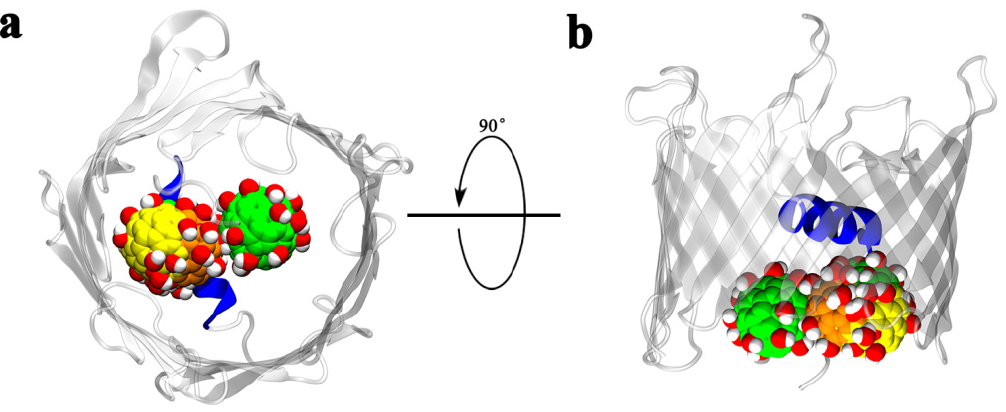
Figure 5. The superimposition of the three representative runs based on the backbone of hVDAC1 to show the relative positions of Gd@C 82 (OH) 22 molecules that penetrated the pore from the IM. Top view from IM is shown in ( a ) and side view in ( b ).